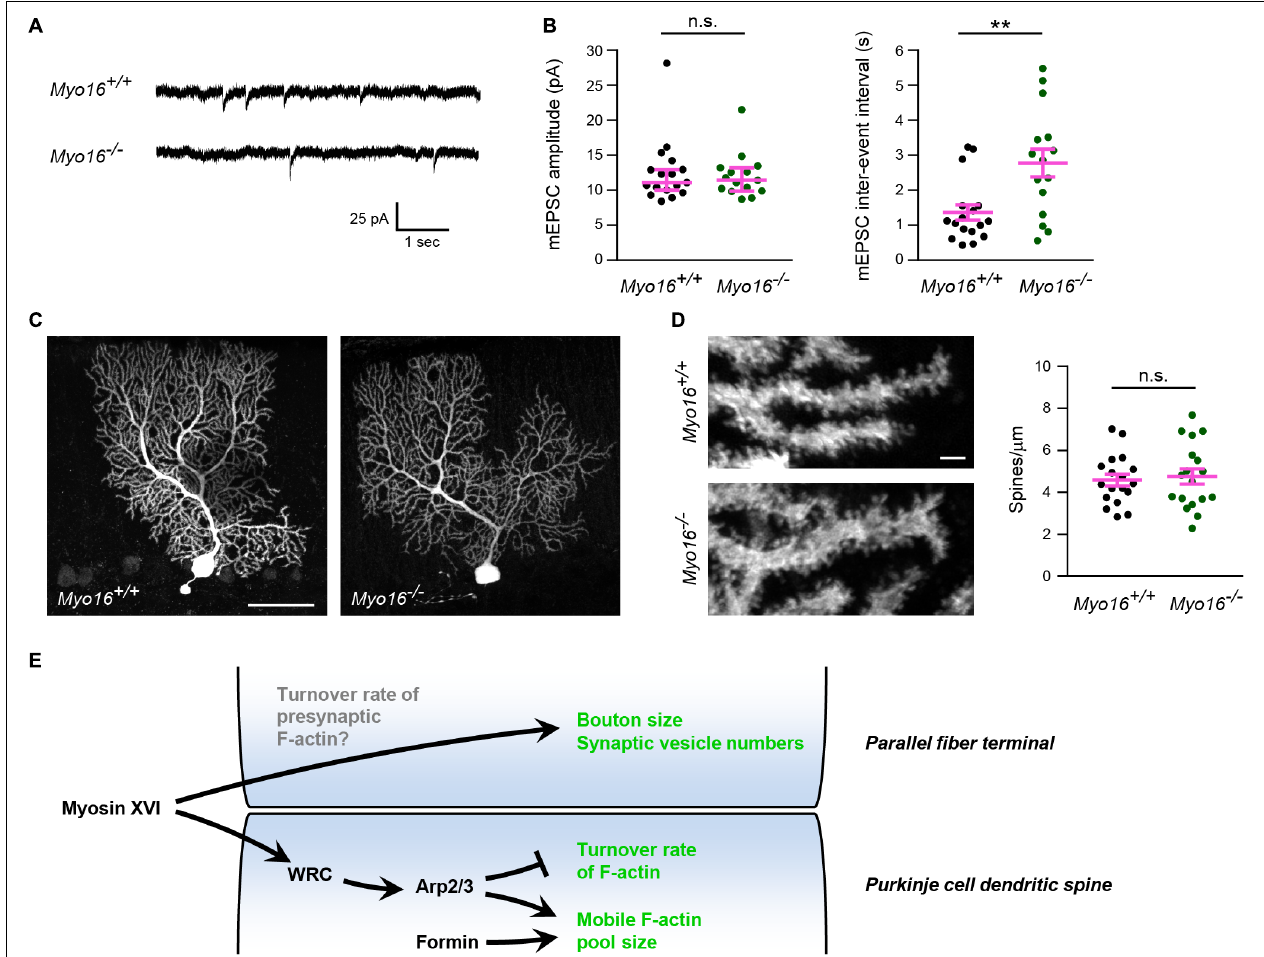
FIGURE 9 | Increased inter-event interval of AMPA receptor-mediated mEPSCs in Myo16 knockout PCs. (A) Example traces of mEPSC measurement from PCs in acute cerebellar slices of 3–4 week old Myo16 em 3 knockout ( Myo16 − / − ) and Myo16 + / + littermate control mice. (B) Quantification of mEPSC amplitudes and inter-event intervals measured as in (A) . Data points represent analyzed PCs ( Myo16 + / + : n = 17 from seven mice; Myo16 − / − : n = 15 from nine mice). mEPSC amplitude: median ± 95% confidence interval is indicated (magenta); p value determined using Mann–Whitney test. mEPSC inter-event interval: mean ± SEM is indicated (magenta); p value determined using Welch’s t -test. (C) PCs filled with biocytin during mEPSC measurement were stained and visualized using confocal microscopy. Images show Z -stack projections. Scale bar, 50 µ m. (D) Higher magnification images of PC dendrites with spines obtained as in (C) . Scale bar, 2 µ m. Graph depicts number of spines per µ m dendrite. Data points represent analyzed PCs, mean ± SEM is indicated (magenta); p value determined using Student’s t -test. (E) Model of the role of myosin XVI at PF-PC synapses. In PC dendritic spines, myosin XVI is required for the attenuation of F-actin turnover. We propose that the myosin functions by promoting WRC activation which, in turn, activates Arp2/3-mediated branched F-actin formation. In addition to WRC and Arp2/3, also formins promote F-actin mobility in PC spines. However, interference with myosin XVI, WRC, and Arp2/3, but not with formins, accelerates F-actin turnover rate, consistent with formins acting in a separate pathway. At the presynaptic side, loss of myosin XVI leads to reduced numbers of synaptic vesicles and terminals of apparently reduced size. This may be a consequence (i) of a role of the myosin at the presynaptic side (e.g., in F-actin turnover) or (ii) of the postsynaptic changes